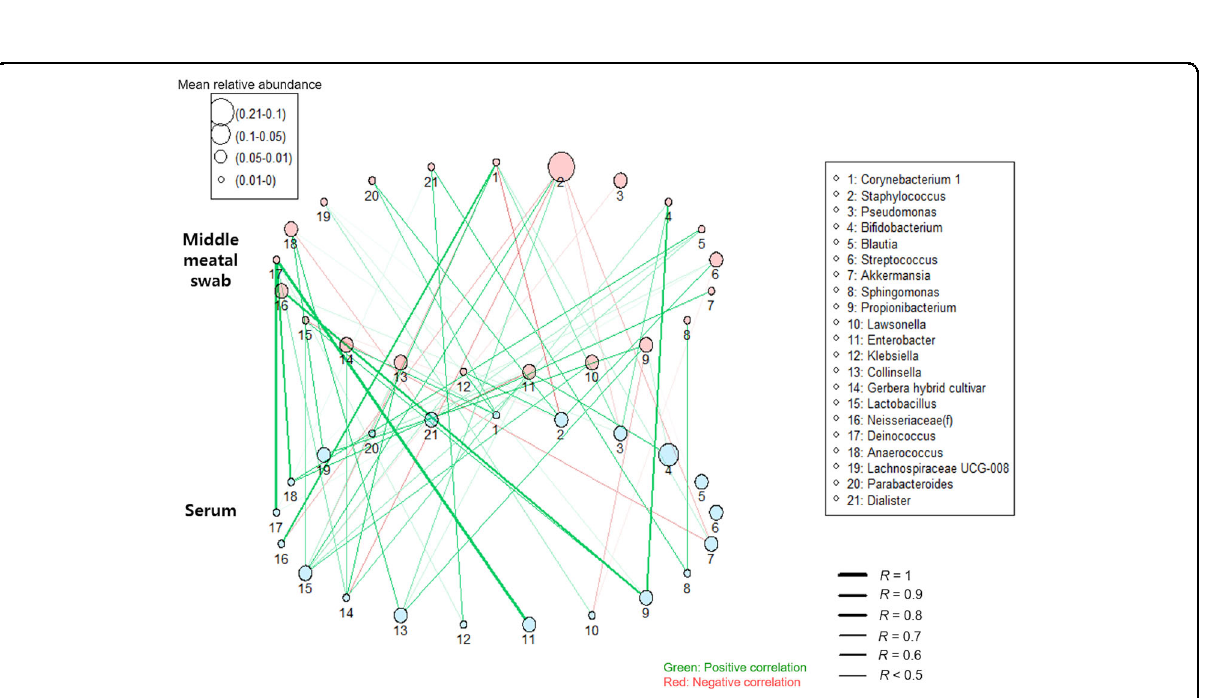
Fig. 4 Correlation between sinus bacteria and serum extracellular vesicles. Deinococcus , Sphingomonas , and Lactobacillus among the sinus bacteria were positively correlated with serum extracellular